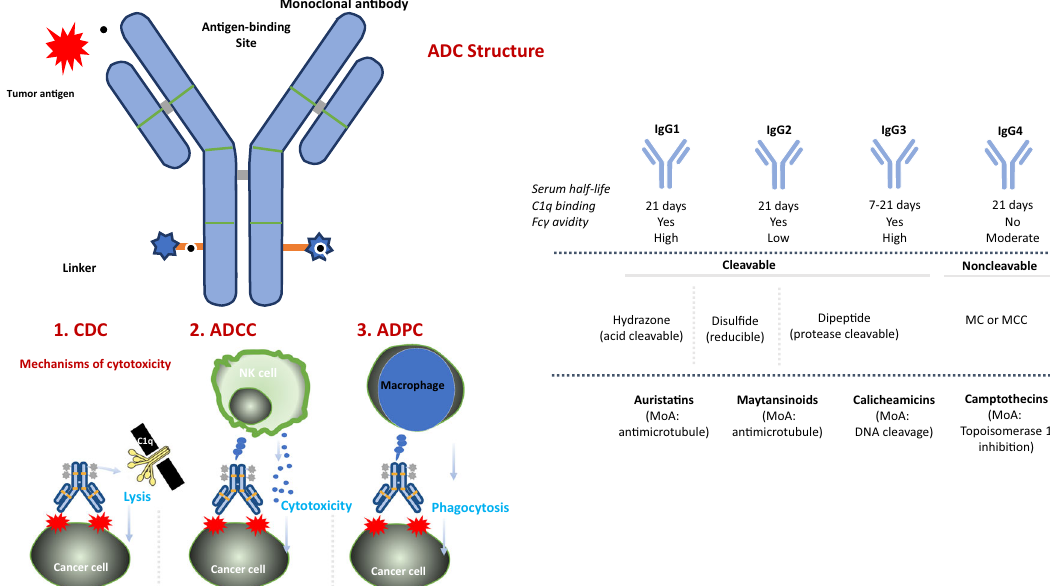
Fig. 1 Structure and components of typical antibody-drug conjugates, including monoclonal antibodies, linkers, and payloads. Antibody: chimeric/humanized monoclonal IgG antibody targeting a protein preferentially expressed on the tumor cell surface. Linker: ensures payload is attached to antibody in plasma but is ef fi ciently released in tumor cells. Linkers can be cleavable (via tumor-associated factors) or non- cleavable (lysosomal degradation); payload: enhances cytotoxicity, although variable drug:antibody ratio affects ef fi cacy and clearance. The antibody component of ADCs engage with immune effector cells to elicit antitumor immunity, including complement-dependent cytotoxicity (CDC), antibody-dependent cell cytotoxicity (ADCC), and antibody-dependent cell phagocytosis (ADCP) effects. MC maleimidocaproyl, MCC maleimidomethyl cyclohexane-1-carboxylate; MoA mechanism of action.